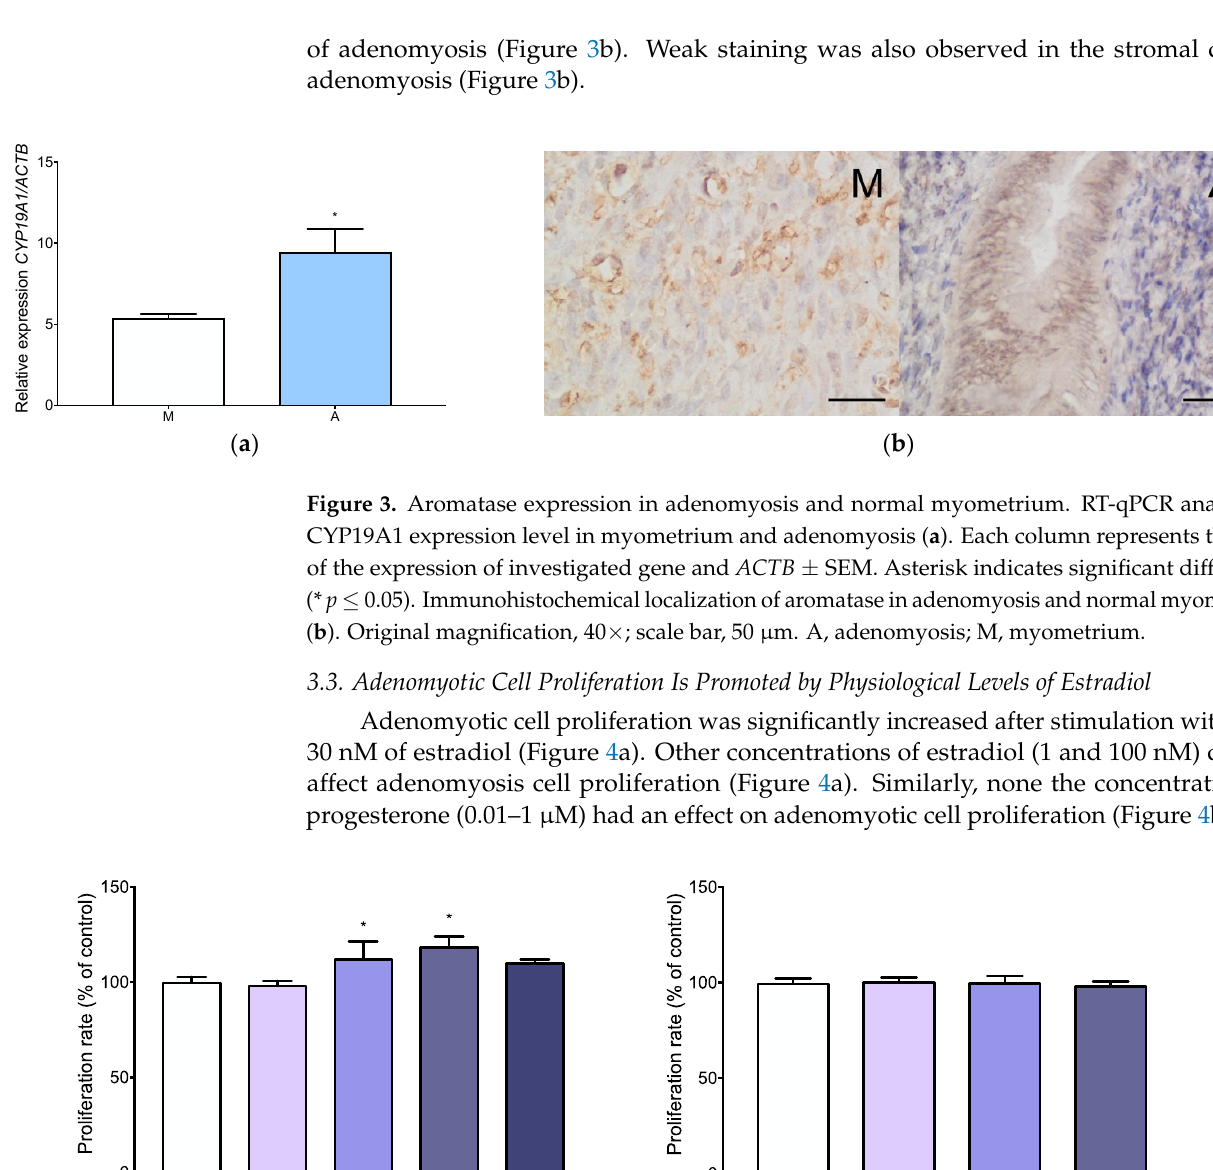
Figure 4. Adenomyotic cells proliferation after estradiol and progesterone stimulations. Adenomyosis cells proliferation rate after estradiol ( a ) and progesterone ( b ) treatment in different concentrations. Cell proliferation of the treated groups is presented as the percentage of the control (considered as 100%). Asterisks indicate significant differences (* p ≤ 0.05).